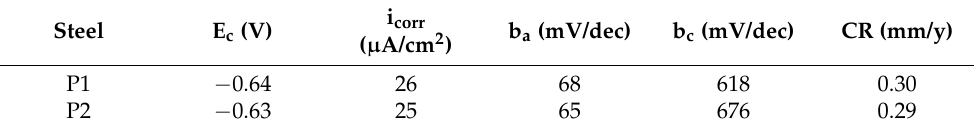
Table 4. Corrosion potentials and corrosion rates for the polished samples in seawater.